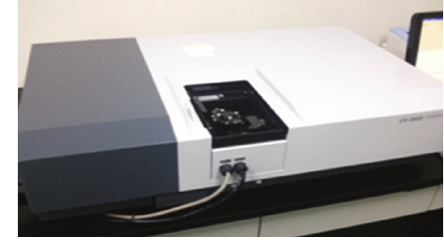
Figure 4: Optical spectrum analyzer.